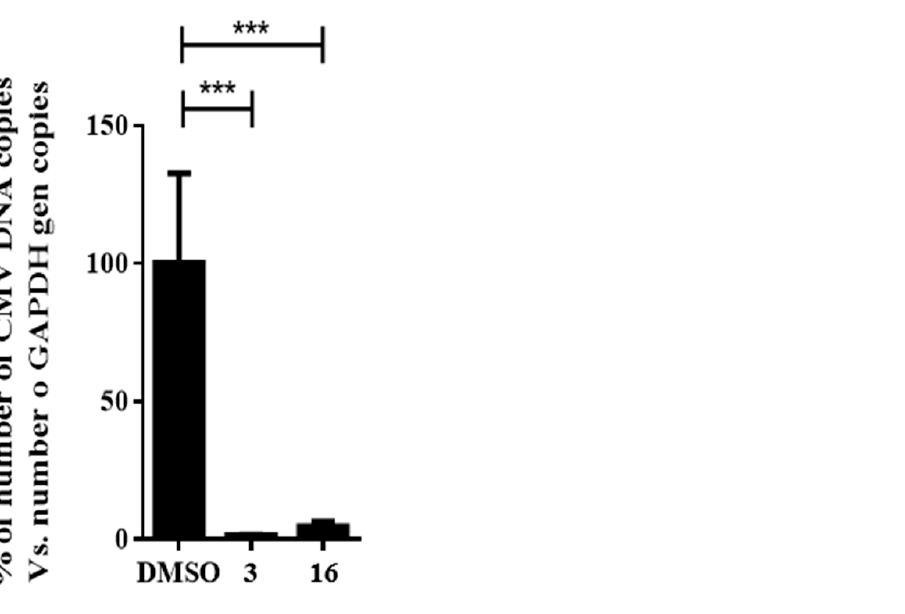
Figure 8. Effect of compound 16 on HCMV replication. Concentration of niclosamide (3) was 5 µ M and compound 16 was tested at 10-fold IC 50 concentration obtained in the HAdV plaque assay. Bars represent means ± SD of triplicate samples. *** p ≤ 0.001.